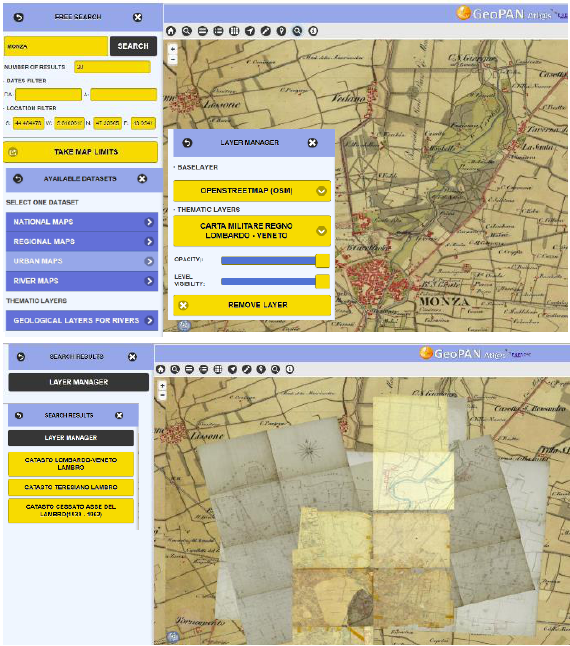
Figure 5. The map search query service supported by the GEOPAN APP. A sample of the georeferenced maps nowadays available on the area selected: the Military Map ( Carta Militare del Lombardo-Veneto ) and the three historical cadasters ( Catasto Teresiano , Catasto Lombardo-Veneto and Cessato Catasto